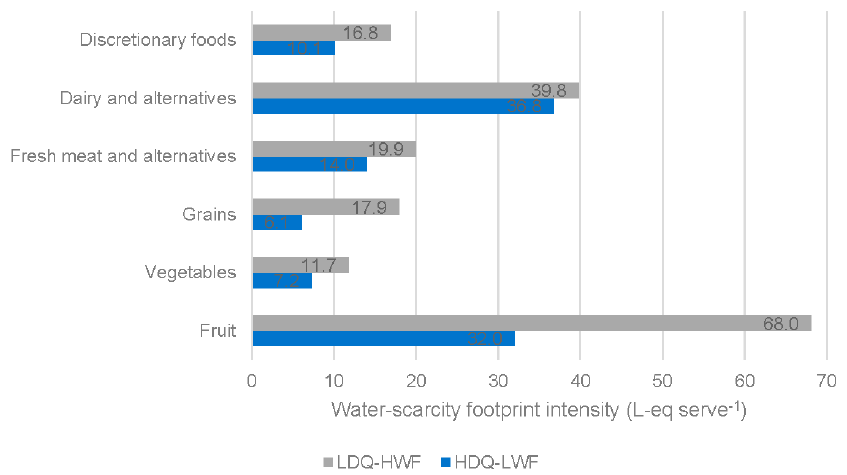
Figure 3. Water-scarcity footprint intensity of major food groups. There exists large differences in water-scarcity footprint intensity between individual foods within some food groups, particularly fruits and grains. Shown here are average results for the higher diet quality and lower water-scarcity footprint (HDQ-LWF) dietary pattern and the lower diet quality and higher water-scarcity footprint (LDQ-HWF) dietary pattern.